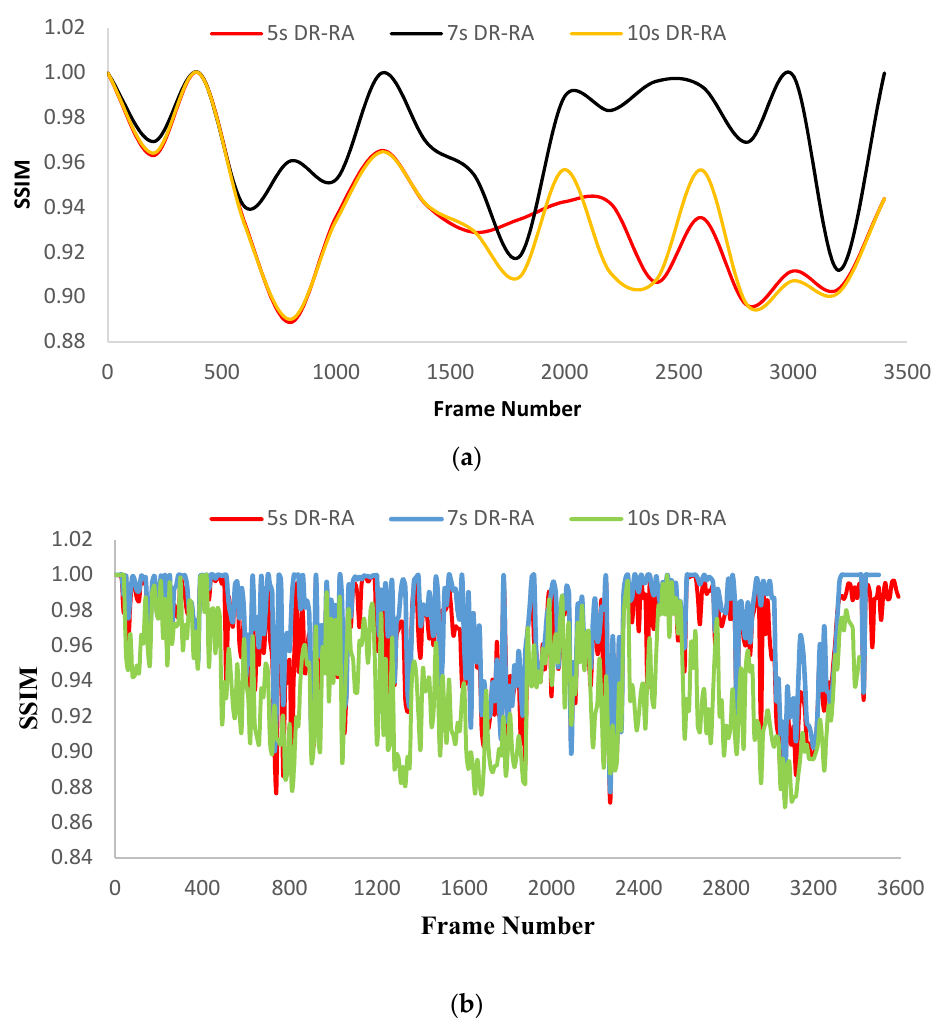
Figure 9. Effects of executing dynamic rerouting algorithm at different times on HD video resolution. ( a ) SSIM values are measured every 10 frames; ( b ) SSIM values are measured every 200 frames.